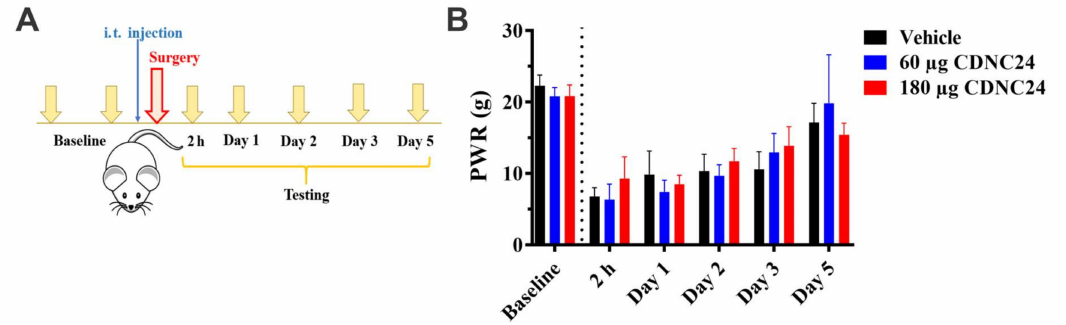
Figure 6. The preemptive administration of CDNC24 does not alleviate post-incisional mechanical hypersensitivity in rats. ( A ). A time-course showing pre-surgical baseline measurements, the timing of intrathecal (i.t.) CDNC24 injection and post-surgical testing time points. ( B ). The preemptive i.t. application of CDNC24 did not a ff ect post-incisional mechanical hypersensitivity in rats ( n = 9 for Vehicle; n = 7 for 60 µ g and 180 µ g CDNC24 groups). Each data point is represented as mean + SD. Data were analyzed using Two-way